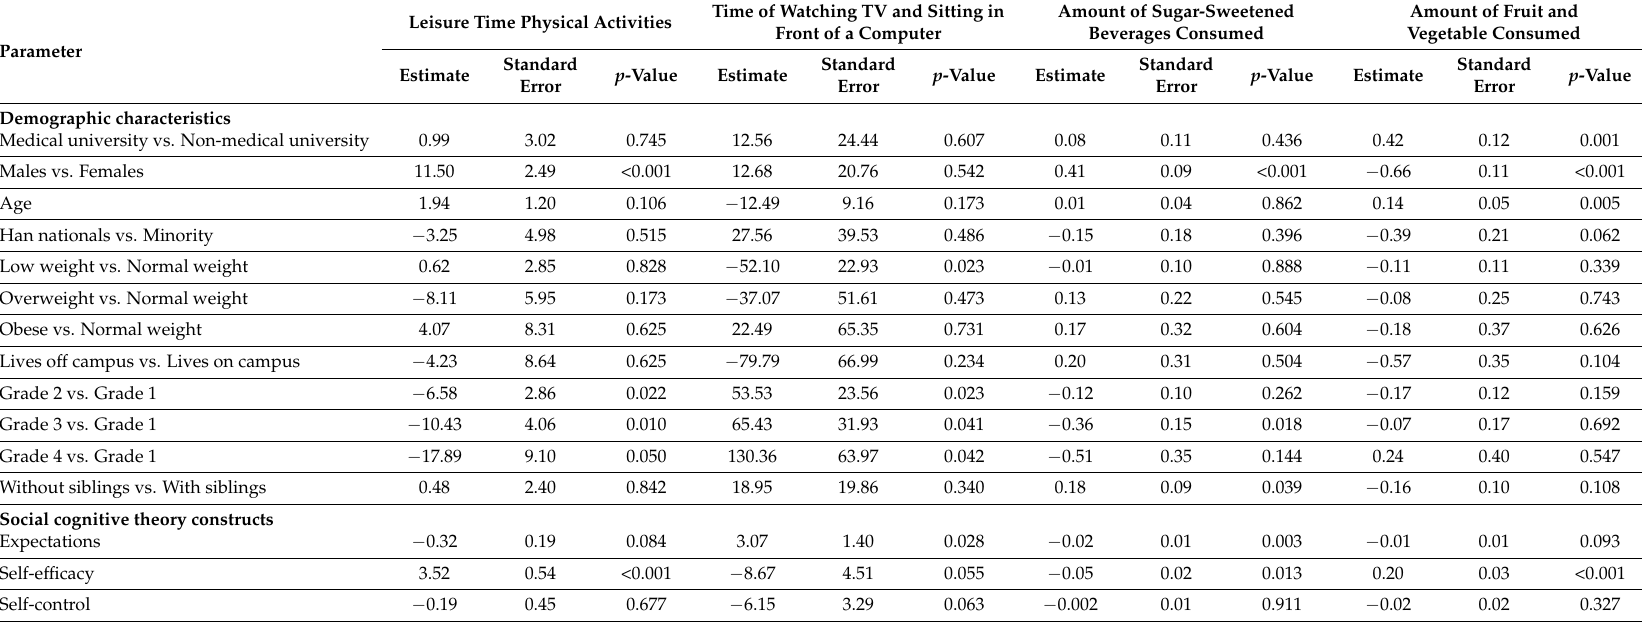
Table 5. Multiple linear regression analysis for the factors that affect the social cognitive theory constructs of physical activities and healthy nutrition behaviors in Chongqing,